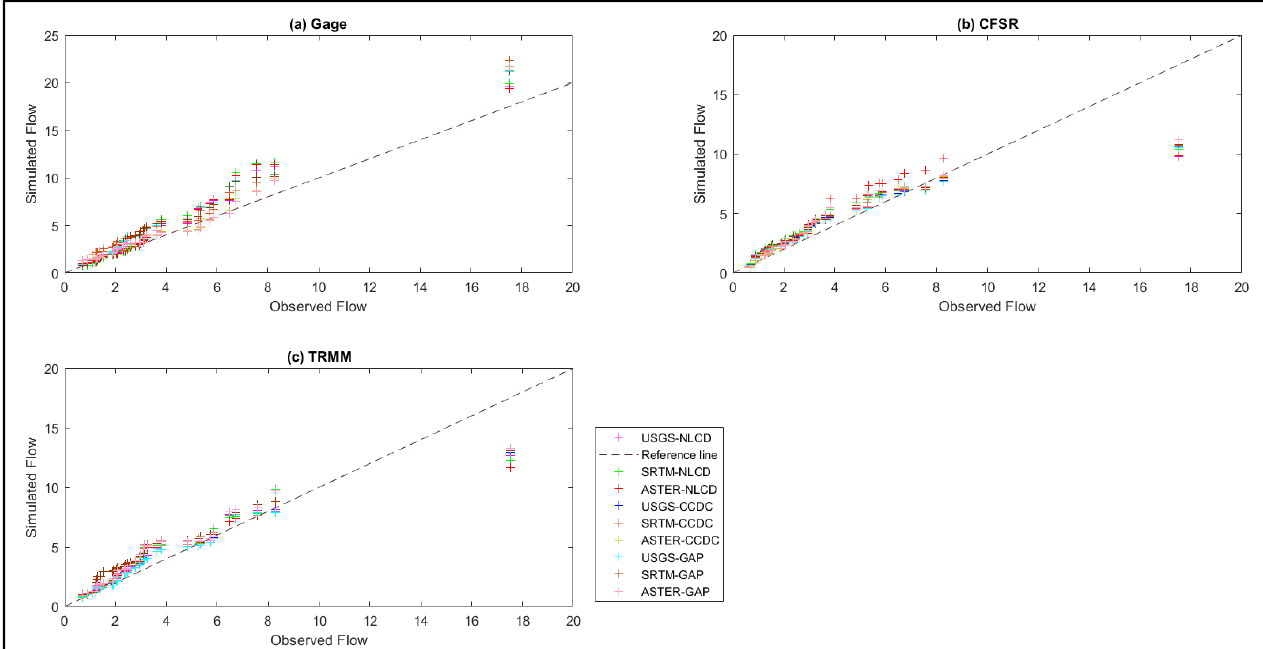
Figure 13. Variation of simulated flows with observed flows was obtained for the three precipitation datasets as ( a ) Gage, ( b ) CFSR, and ( c ) TRMM with nine different combinations for the Peachtree watershed.